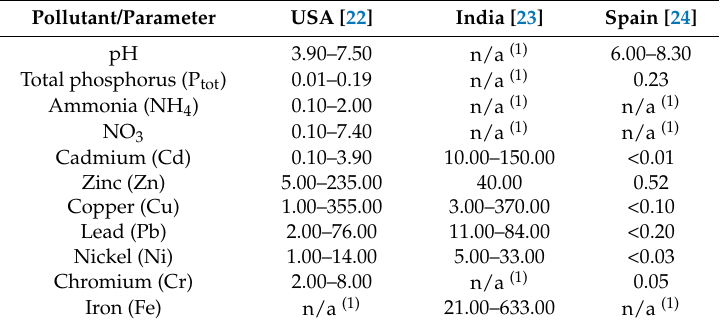
Table 1. Pollutants measured in stormwater runoff in the USA, India, and Spain.